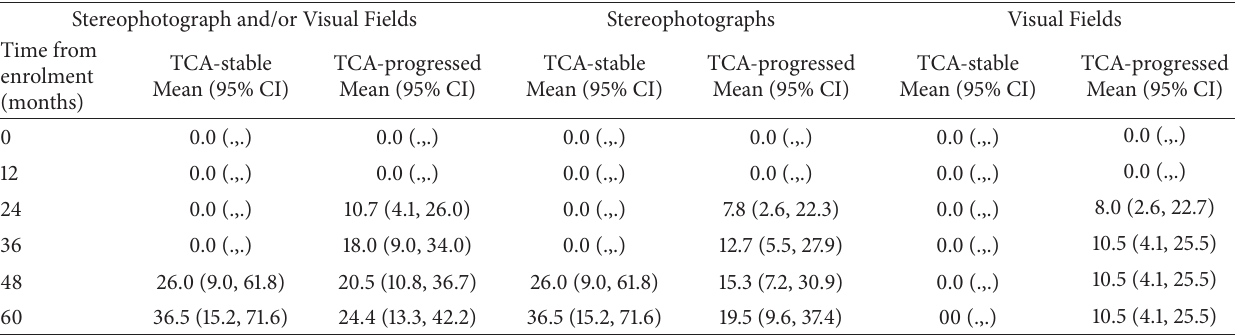
Table 5: Kaplan-Meier cumulative probabilities of stereophotograph (SPG) and/or visual field (VF) progression, SPG only progression, and VF only progression, from recruitment, by topography change analysis (TCA) status. Stereophotograph and/or Visual Fields Stereophotographs Visual